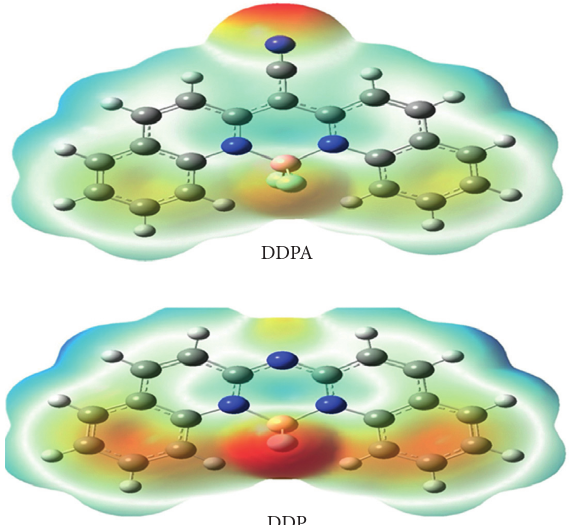
Figure 6: MESP maps for DDP and DDPA molecular structures using the B3LYP/6-31G (d) level of theory.